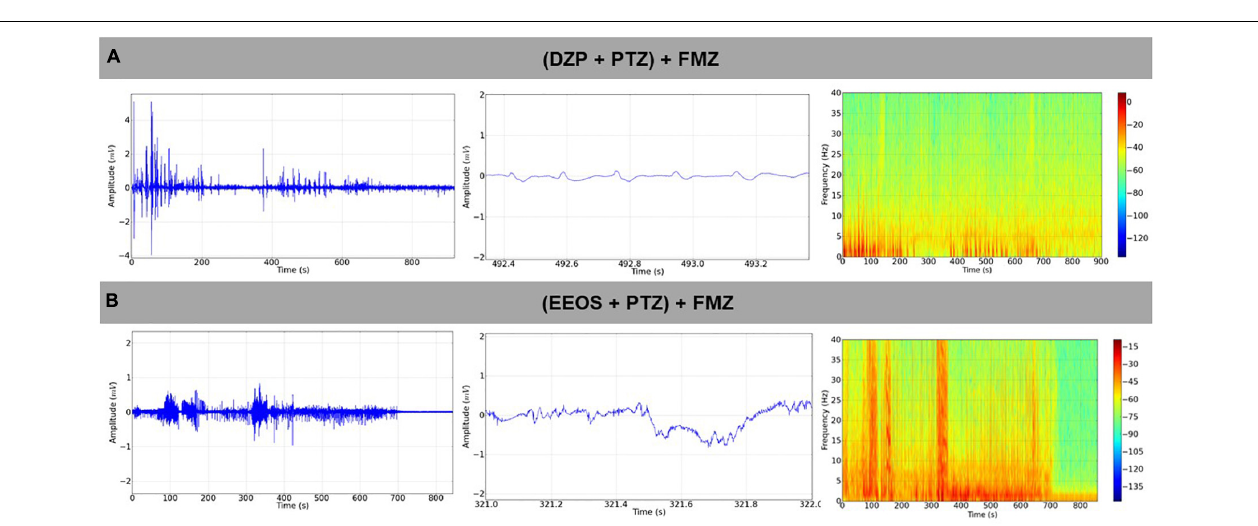
Frontiers in Cellular Neuroscience |